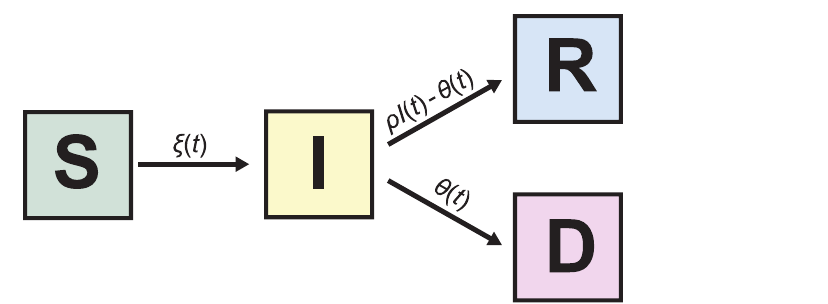
Fig 3. The SIRD model. Each of the four compartments quantifies the number of population members with that disease status: S for susceptible, I for infectious, R for recovered and D for dead. The arrows indicate possible transitions between disease